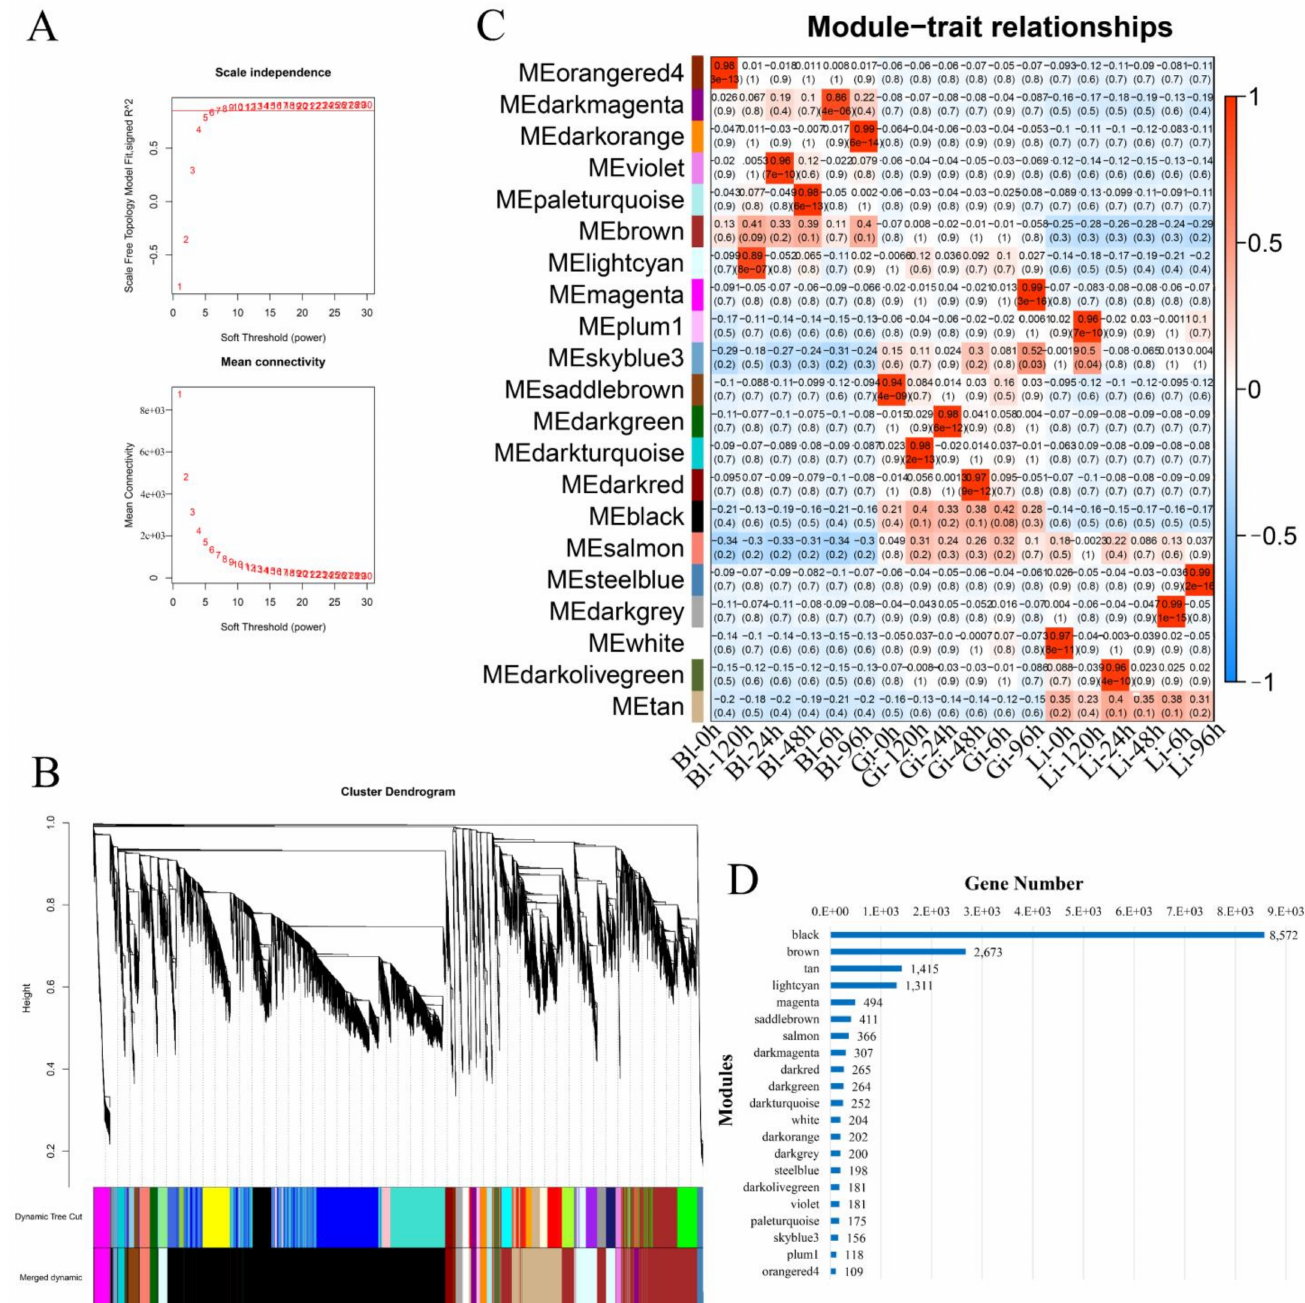
Figure 3. Weighted gene co-expression network analysis (WGCNA) of gene expressions. ( A ) Scale-free topology model fit and gene mean connectivity under different soft threshold power; ( B ) Clustering dendrogram of genes and module division by WGCNA. The 21 co-expression modules are shown in different colors; ( C ) Heat map for the association of gene co-expression network modules with samples; ( D ) Histogram of the number of genes in each